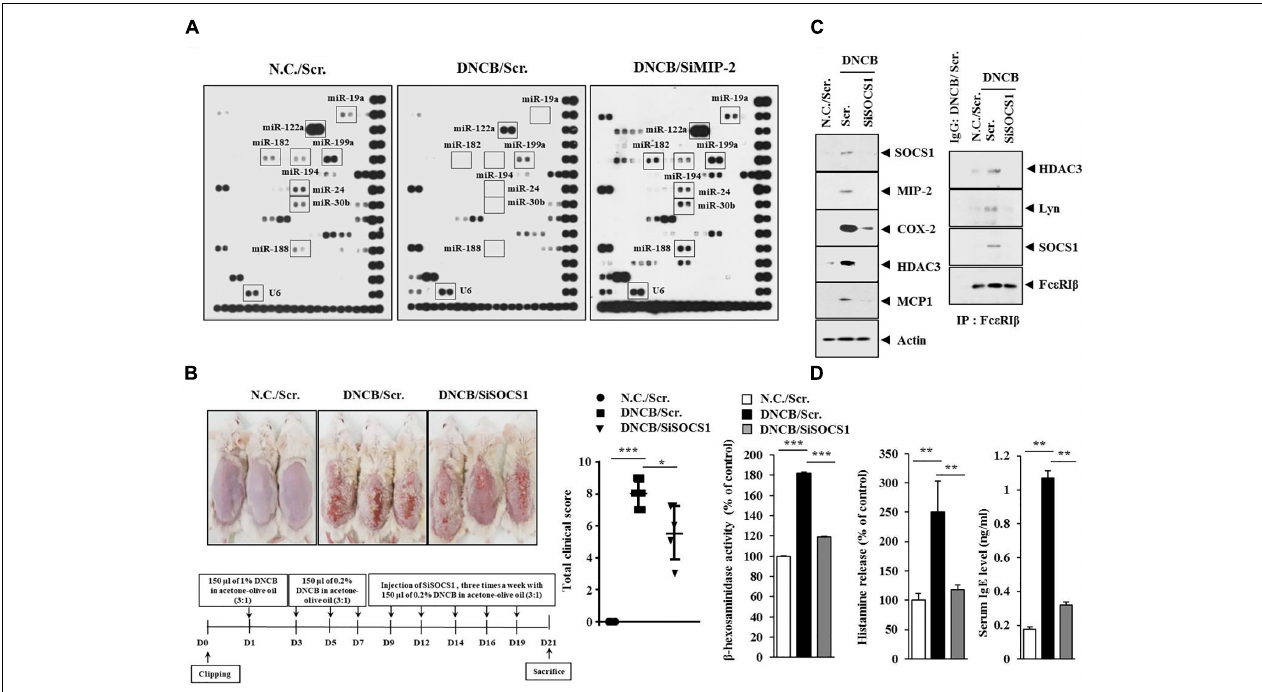
FIGURE 6 | Suppressor of cytokine signaling 1 (SOCS1) is necessary for DNCB-induced AD. (A) Skin tissue lysates of BALB/c mice of each experimental group were subjected to miRNA array analysis. (B) Shows the experimental time line to determine the effect of MIP-2 on AD (lower). Upper figure shows the effect of SOCS1 on clinical symptoms associated with AD. ∗ p < 0.05; ∗∗∗ p < 0.0005. (C) Tissue lysates from the mice of each experimental group were subjected to western blot or immunoprecipitation by employing the indicated antibody (2 µ g/ml). Tissue lysates from BALB/c mouse injected with scr. following the induction of AD was also immunoprecipitated with isotype-matched IgG antibody (2 µ g/ml). (D) Tissue lysates from the mice of each experimental group were subjected to ß-hexosaminidase activity assays (left). Sera of BALB/c mice were employed for the determination of the amount of histamine released (middle) and IgE level (right). ∗∗ p < 0.005; ∗∗∗ p <